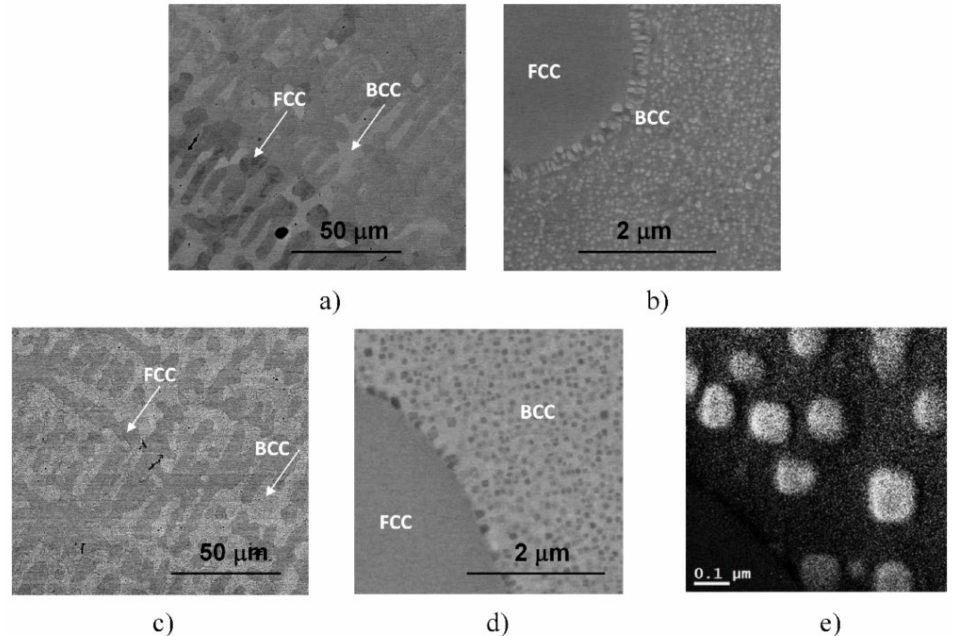
Figure 3. SEM images taken on the samples heat-treated for 1 h at 923 K, quick-cooled by water quenching ( a , b ) and at 1150 K, but slowly cooled with the furnace ( c , d ). The microstructure of the later sample was also investigated by EFTEM, indicating an enhanced amount of Cr inside the cuboidal-shaped particles in the Cr-map ( e